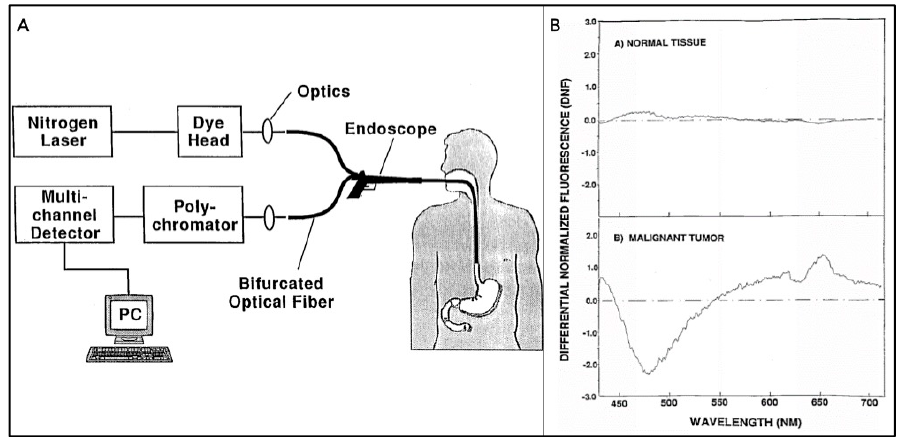
Figure 1. ( A ) Schematic diagram of the instrumental system used for laser-induced fluorescence diagnosis of esophageal cancer. ( B ) Example of a differential normalized fluorescence curve of ( A ) a normal esophageal mucosa; ( B ) an esophageal adenocarcinoma. The DNF curve ( B ) clearly shows the negative peak at 475 ± 480 nm, which is characteristic of malignant tissue in the esophagus. Adapted from [4].